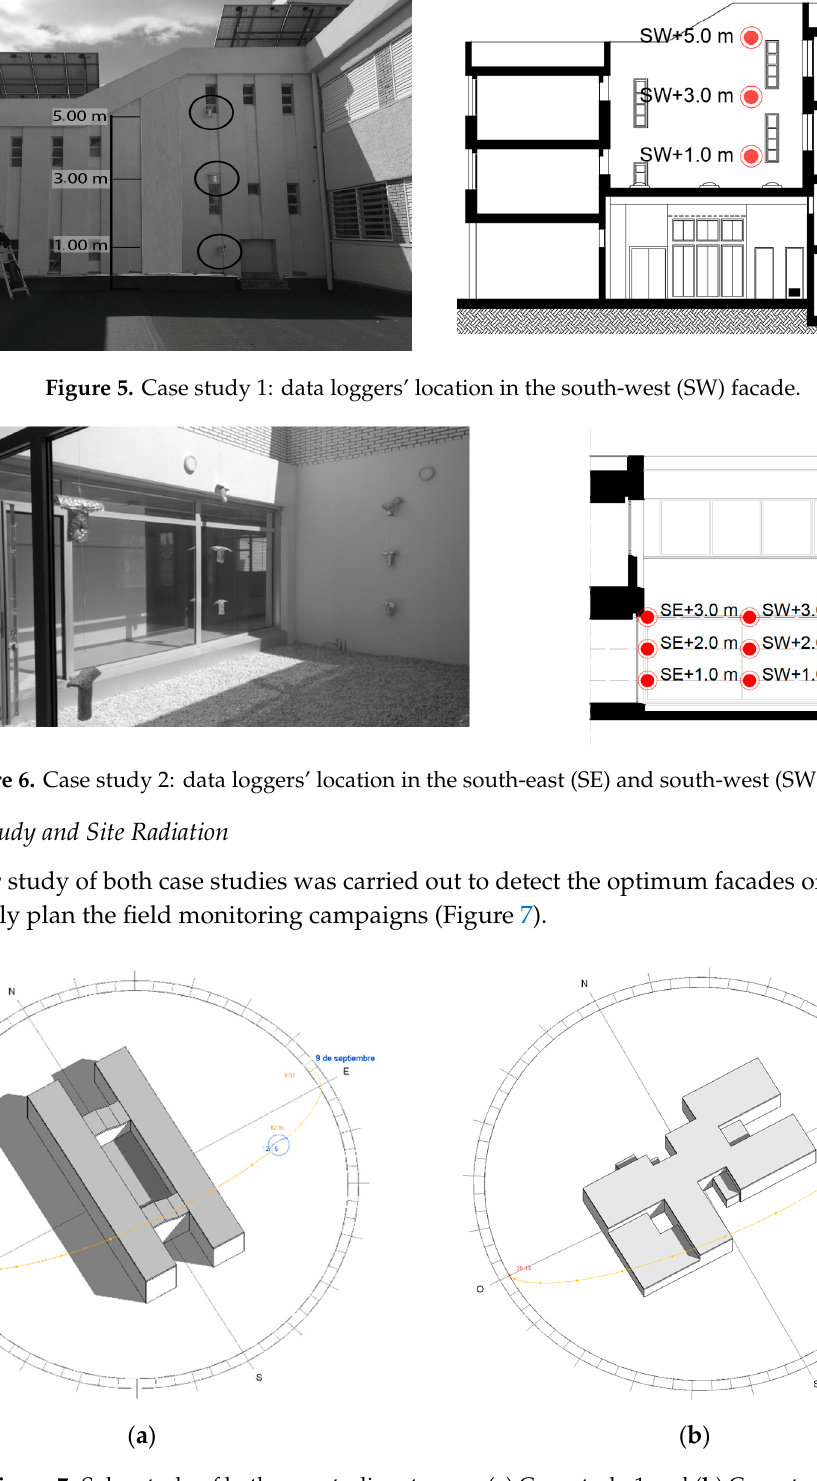
Figure 7. Solar study of both case studies at noon: ( a ) Case study 1 and ( b ) Case study 2.